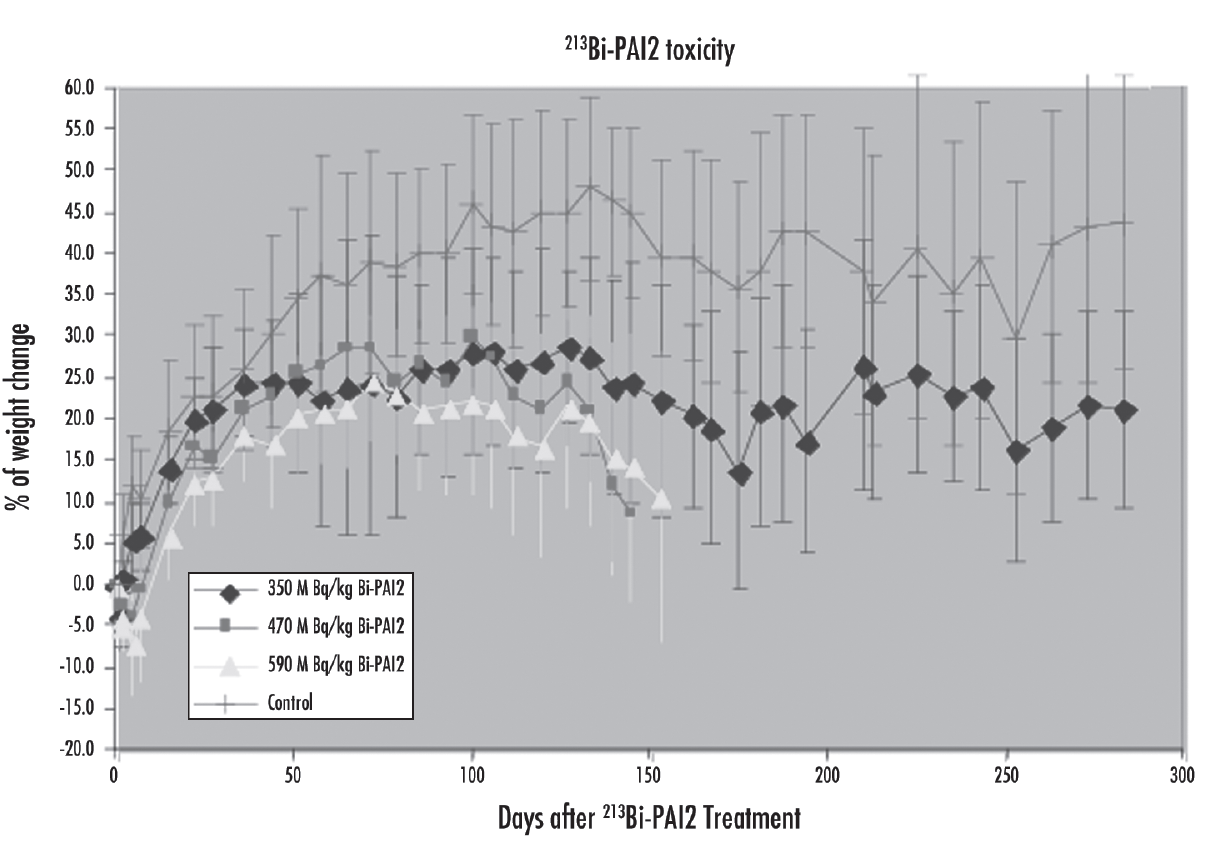
Figure 7. Maximum tolerance dose for 213 Bi-PAI2 in mice. Only the 350 MBq/kg group maintained a steady bodyweight